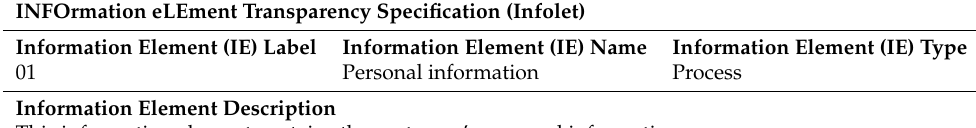
Table A2. Infolet for Personal Information.